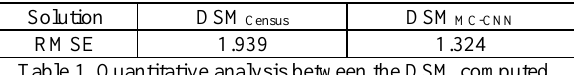
considered matching cost computation methods (red and